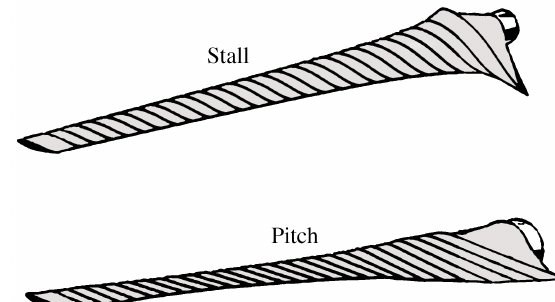
Figure 3. Blade geometry.